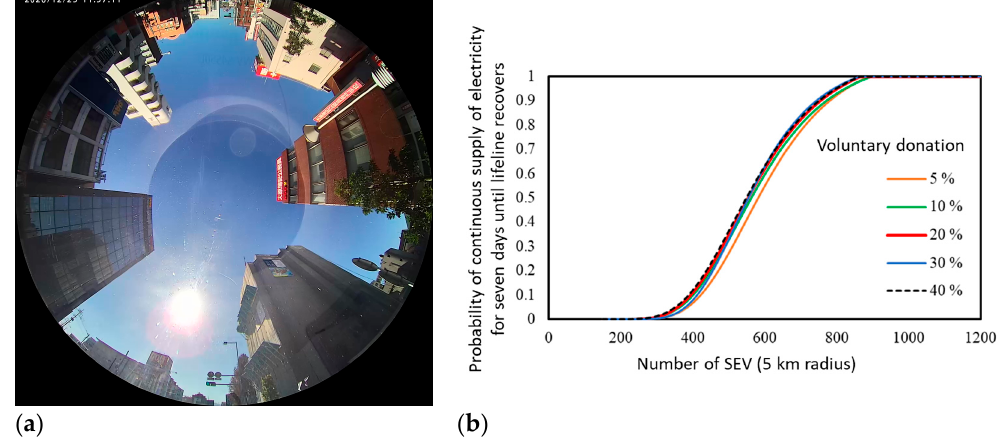
Figure 18. Probability of sustaining resilience energy for a week in building zone: ( a ) fisheye image; ( b ) probability curves.